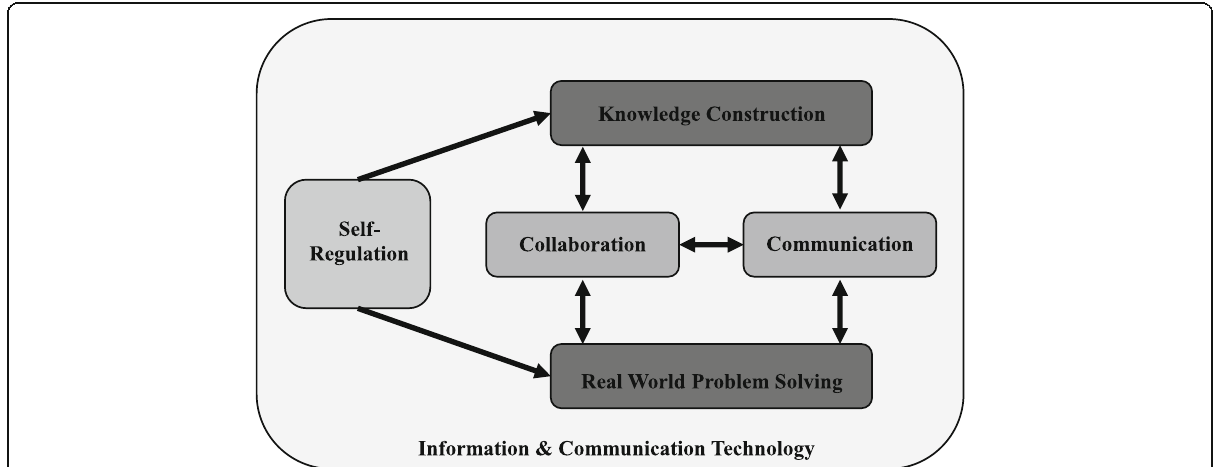
Fig. 1 Working hypothesis of how 21 st Century skills work together to build a 21 st Century